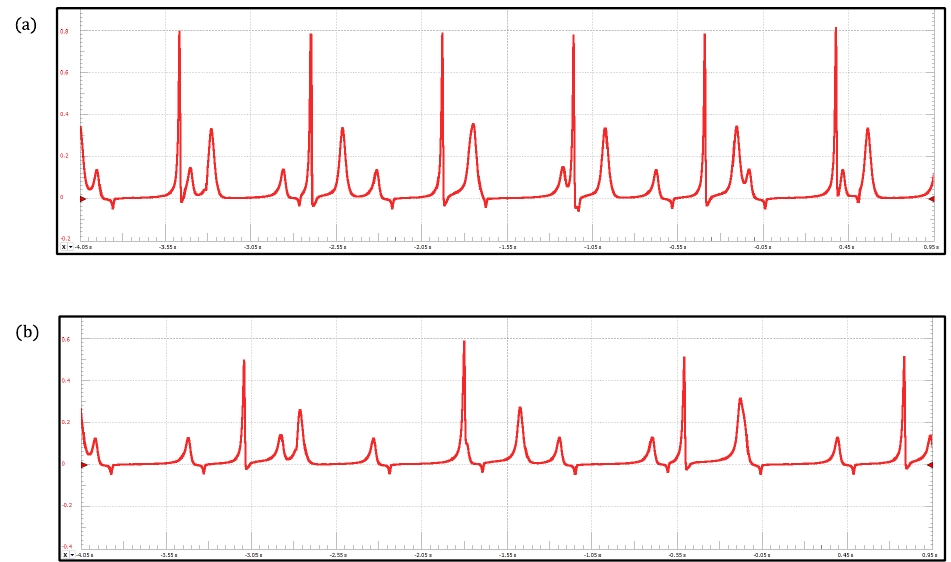
Figure 5. ECG waveforms obtained with the heterogeneous oscillator model of the cardiac conduction system: ( a ) Complete SA–AV block and ( b ) Complete AV–HP